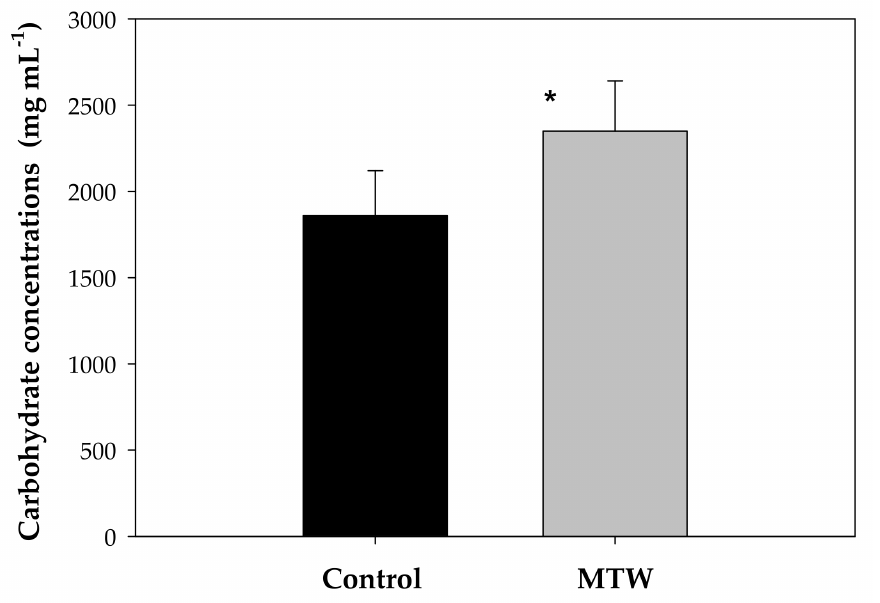
Figure 7. Carbohydrate concentrations in Phaseolus vulgaris L. grown with magnetically treated water * indicates statistically significant differences ( p < 0.05). Control: plants grown without magnetically treated water, MTW: plants grown with magnetically treated water under a static magnetic field between 100 and 160